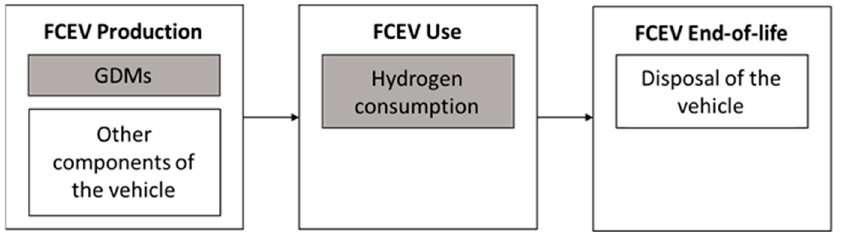
Figure 2. System boundaries of the LCA. Grey boxes indicate the phases of the vehicle life cycle that were considered in scenario A, while in scenario B all the phases (i.e., both grey and white boxes) were included in the assessment.